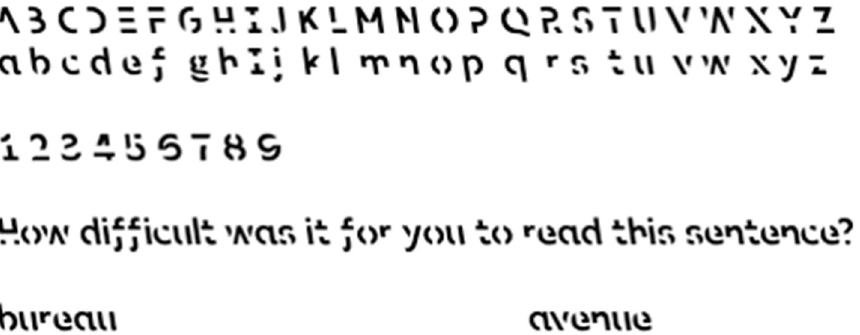
Figure 1. Sample of Sans Forgetica (SF) typeface. (SF is licensed under the Creative Commons At- cessed on 15 November 2018)).